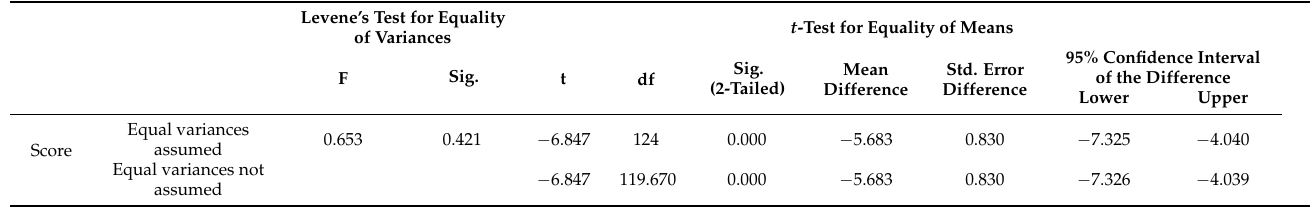
Table 2. Independent Samples Test for E.G.—Intervention Program.